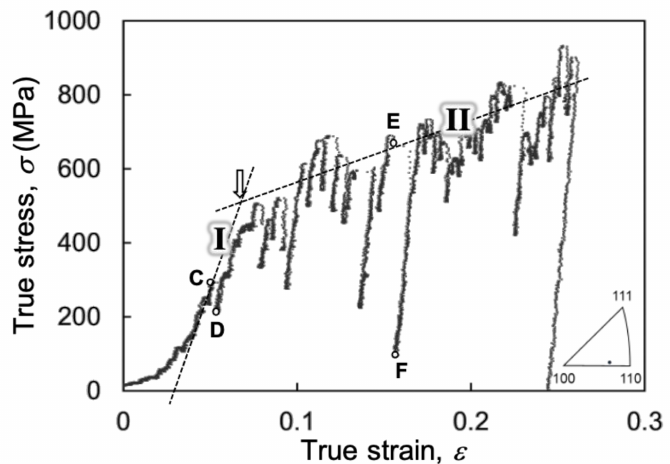
Figure 3. S-S curve of as-FIB Al pillar. Points C-F on the S-S curve correspond to snapshots in Figure 4c–f, respectively. The compression direction is shown by the stereographic triangle at the bottom right of the S–S